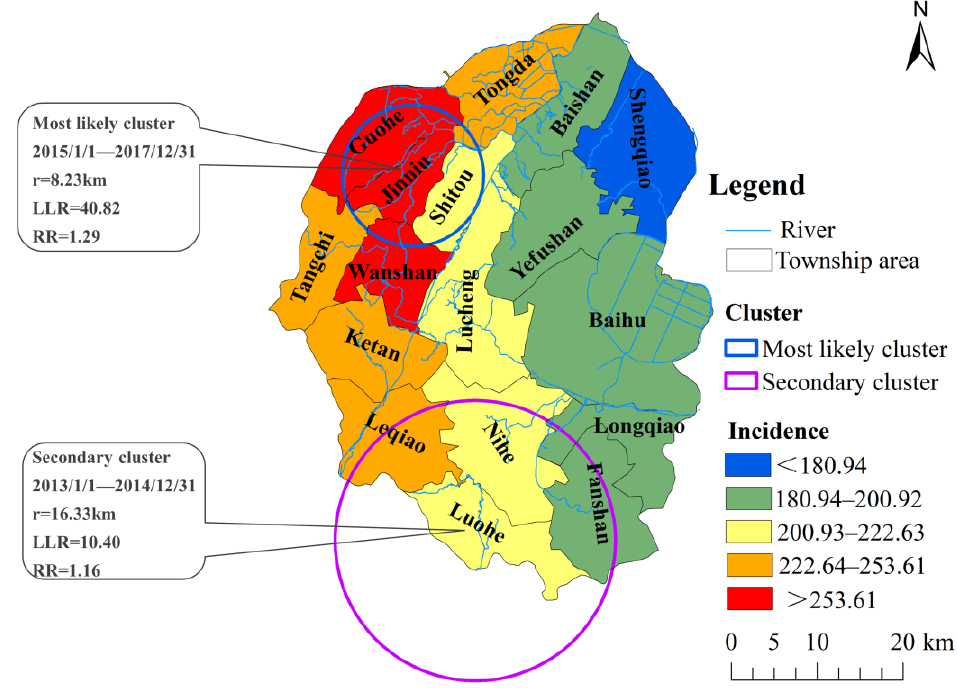
Figure 5. Spatiotemporal clustering of the incidence of digestive tract cancer in Lujiang County from 2012 to 2017. One most likely cluster and one secondary clusters were found using spatiotemporal scanning, which indicated an obvious trend of spatiotemporal clustering for DTC in Lujiang County. The high-risk clusters were predominantly located in the northwest and southwest of Lujiang County.